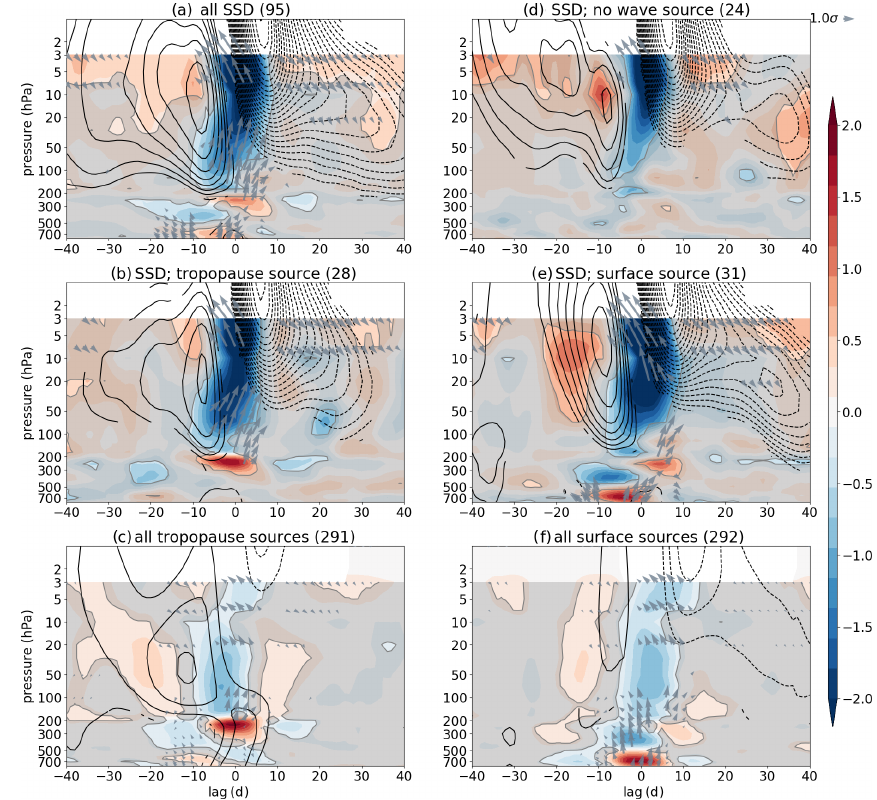
Figure 7. Similar to Fig. 6 but for ERA-20C data. Note that here the k = 1 standardized EP flux divergence and standardized EP fluxes (shading and arrows, respectively) are shown (and k = 1 wave-source events were identified). Data are averaged between 45 and 75 ◦